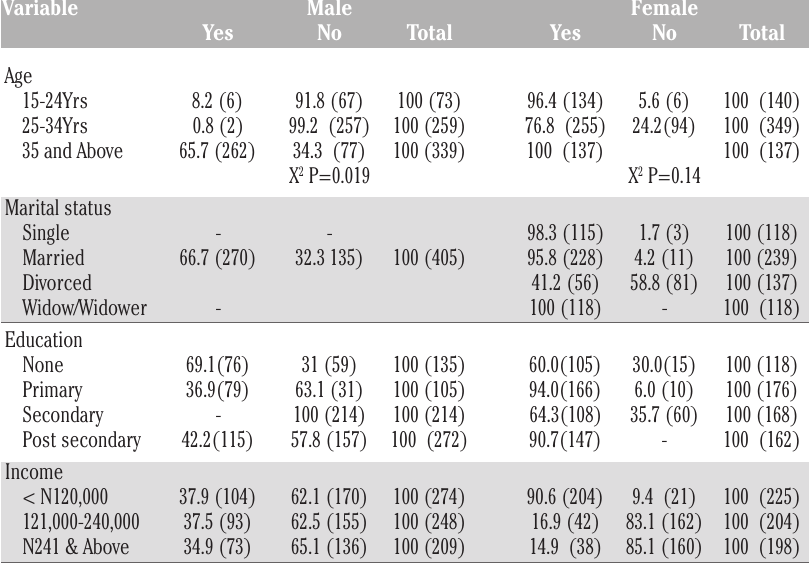
Table 5. Bivariate analysis of some socio-economic characteristics of respondents by ever contracted STI’s.